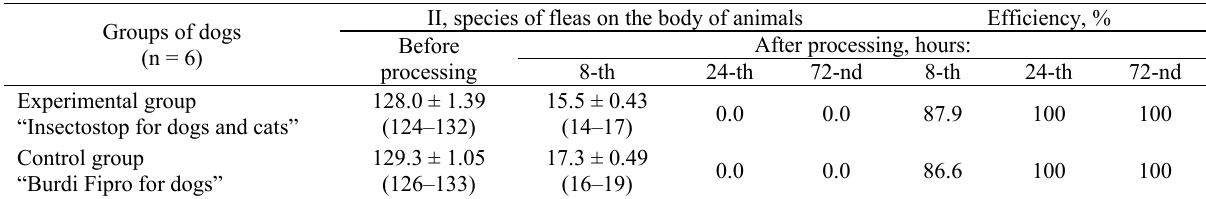
Efficiency of the drug “Insectostop for dogs and cats” and the reference drug “Bourdi Fipro for dogs” for S і phonapterosis of dogs (M ± m) II, species of fleas on the body of animals Groups of dogs